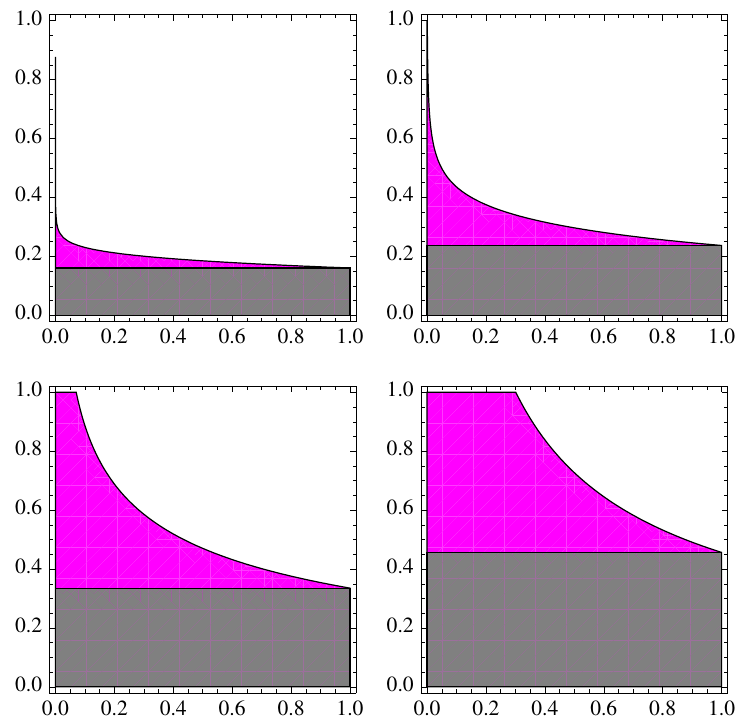
Figure 2. Domains of parameters of Newton’s method associated with Corollary 4 (magenta region) and Theorem 1 (gray region) for p = 1